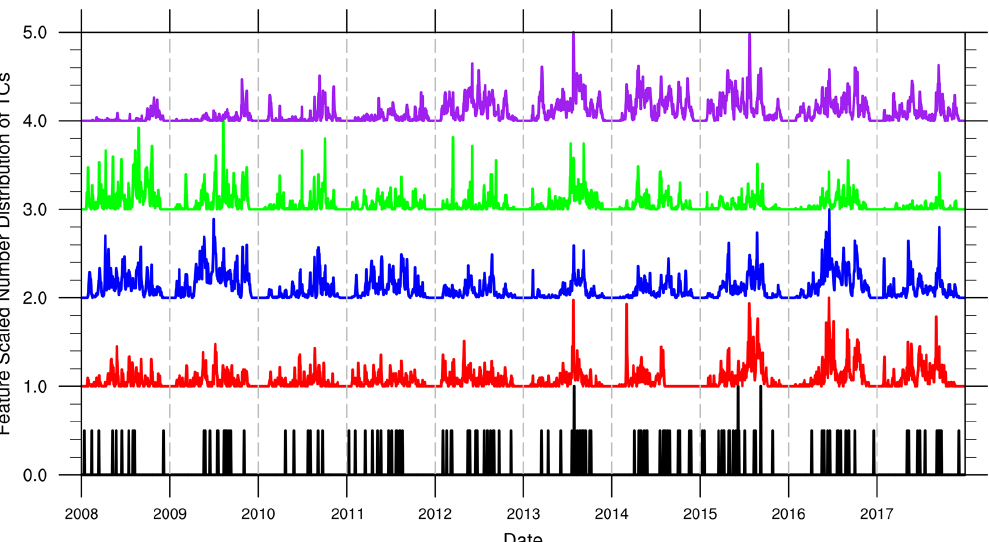
Figure 3. Feature scaled time series of the number of TCs which are first identified in each day in the TPEPS TC event set (CMA: red, ECMWF: blue, JMA: green, NCEP: purple) and the JRA-55 event set (black). For visual convenience, the time series of CMA, ECMWF, JMA, and NCEP are shifted by 1, 2, 3, and 4,